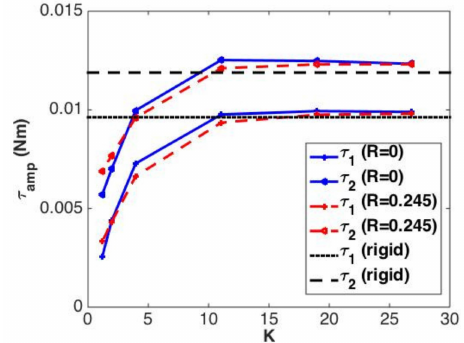
Figure 11. Torque amplitude under different